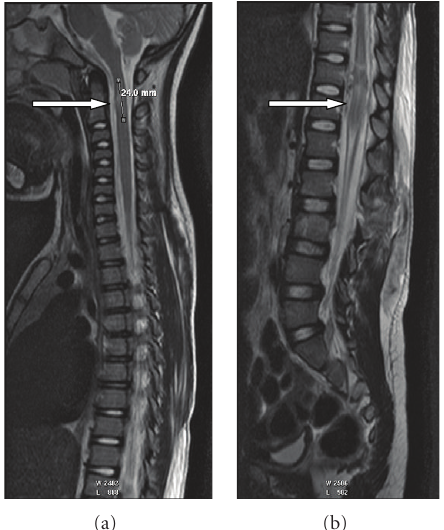
Figure 1: Lateral MRI images of the spinal cord at the cervical level (a) and the lumbar level (b). The spinal injuries are indicated with white arrows.